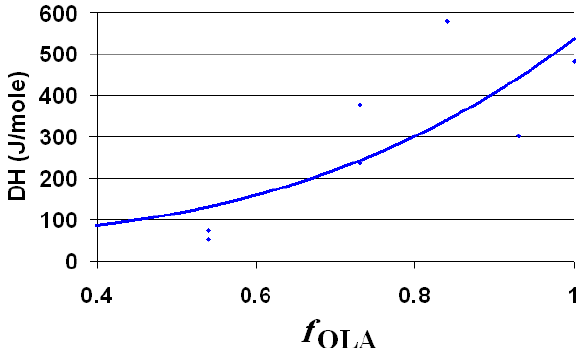
Figure 7. The melting enthalpy of 1 mole of hydrophobic component (OLA + ODTMOS) as function of molar ratio of OLA ( f OLA = mole OLA/mole (OLA + ODTMOS)).